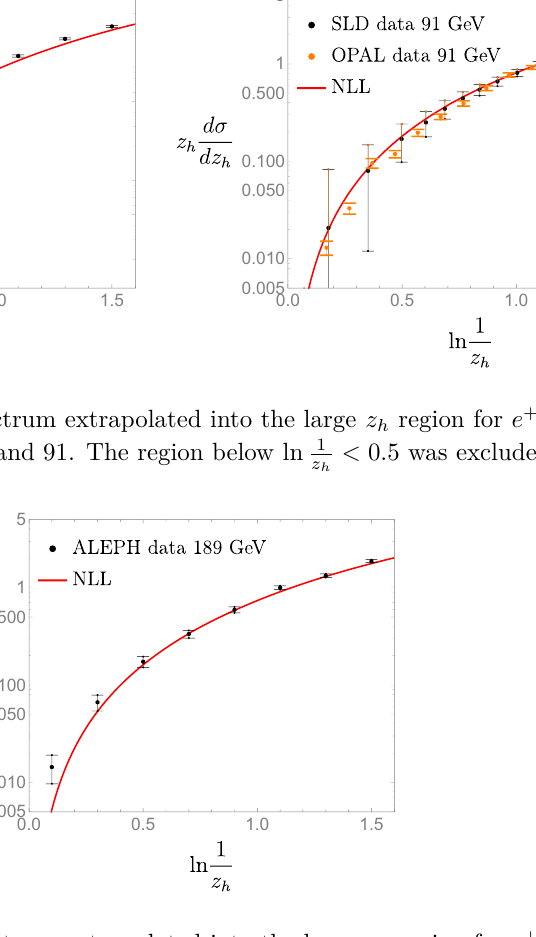
< 0.5 was excluded from the z h